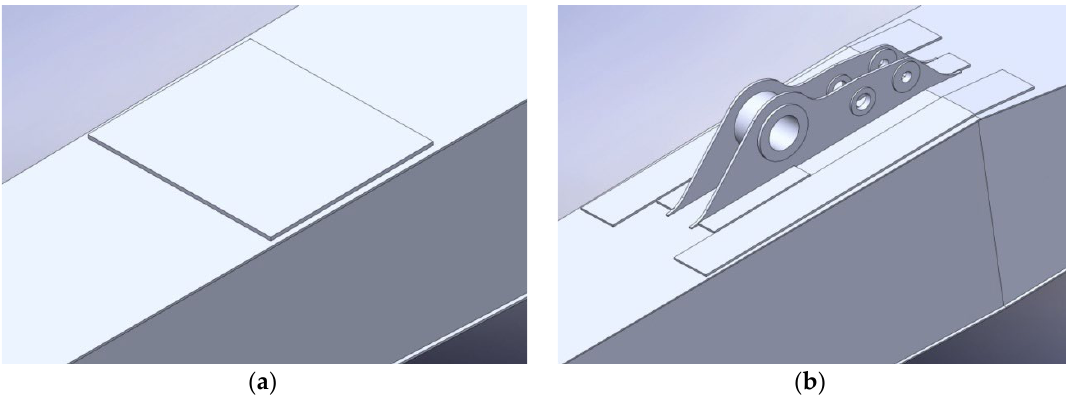
Figure 3. Plated arm (a) middle arm section (b) middle hinge section.